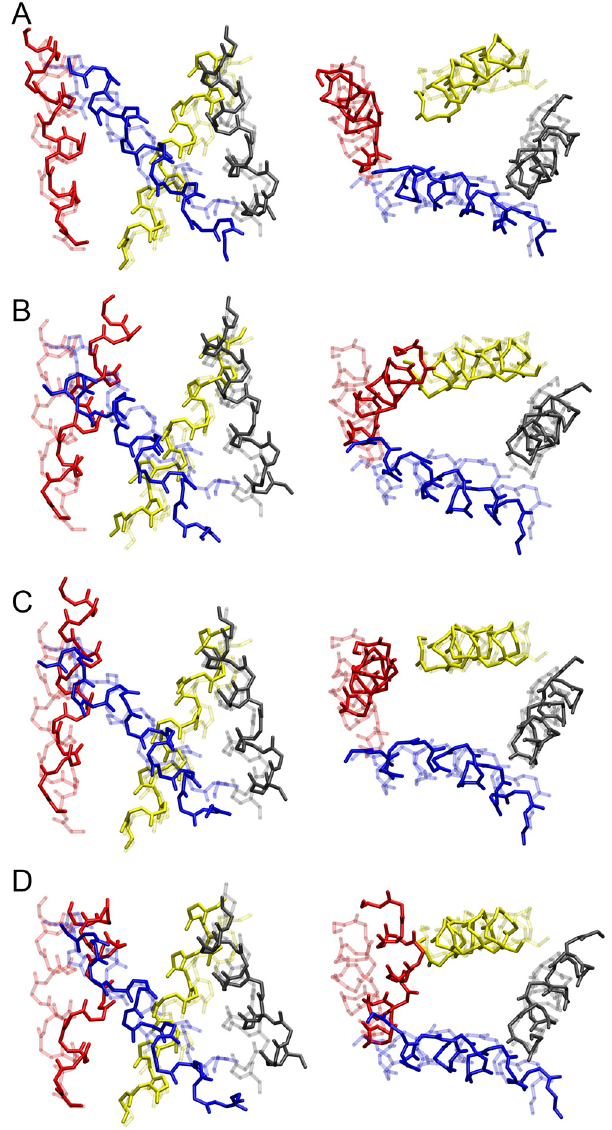
Fig 5. Superimposition of the initial and final configurations of the four models of the VSD. (A) model- 1, (B) model-2, (C) model-3, and (D) model-4. The initial and final configurations of the backbone atoms are represented in transparent and solid sticks,